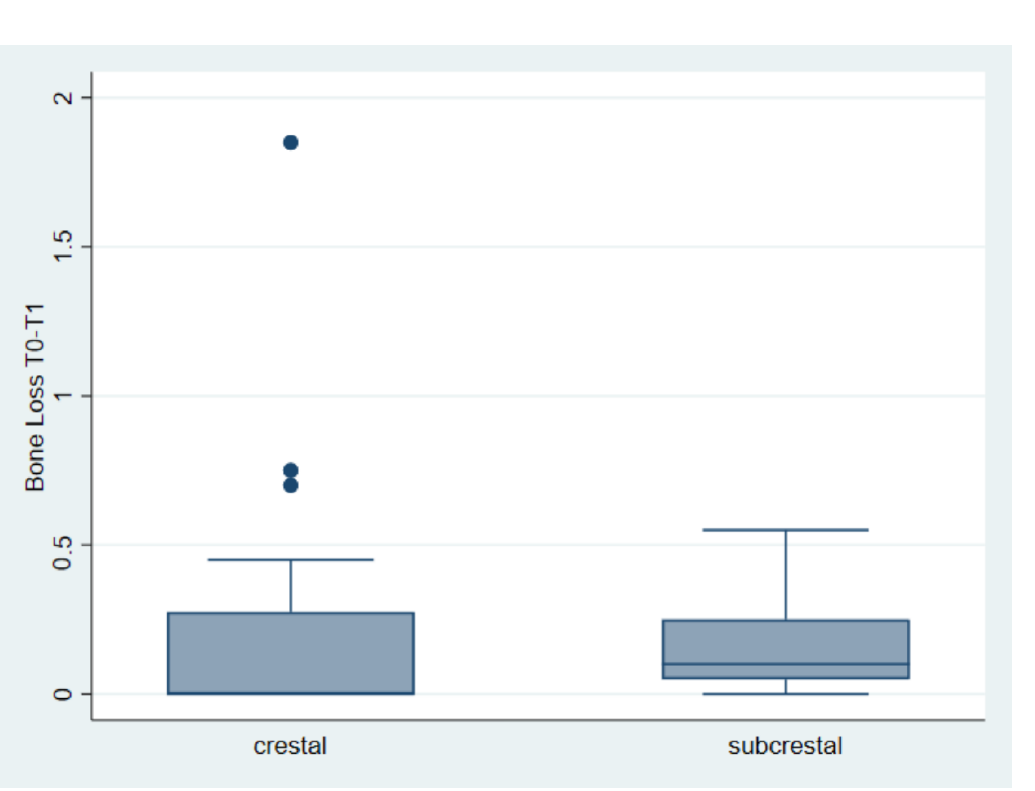
Figure 3. Bone loss (mm) in crestal vs. subcrestal implants between the first and second measurement (T0–T1). Bone loss of 0.19 mm for crestal implants and 0.15 mm for subcrestal implants. The second comparison considers bone loss between the second and third measure- ments. The mean is 0.17 mm for the crestal placement and 0.22 mm for the subcrestal placement. The test returned us a t = −1 .13, with a p = 0.26 (Table 4 and Figure 4). Table 4. Bone loss in crestal and subcrestal implants.